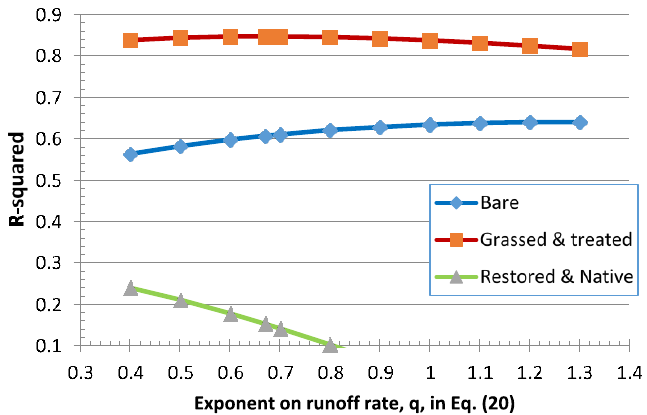
Figure 9. Dependence of linear regression R 2 values on exponent of runoff rate in stream power function when related to soil detachment rates from granitic RS plots.